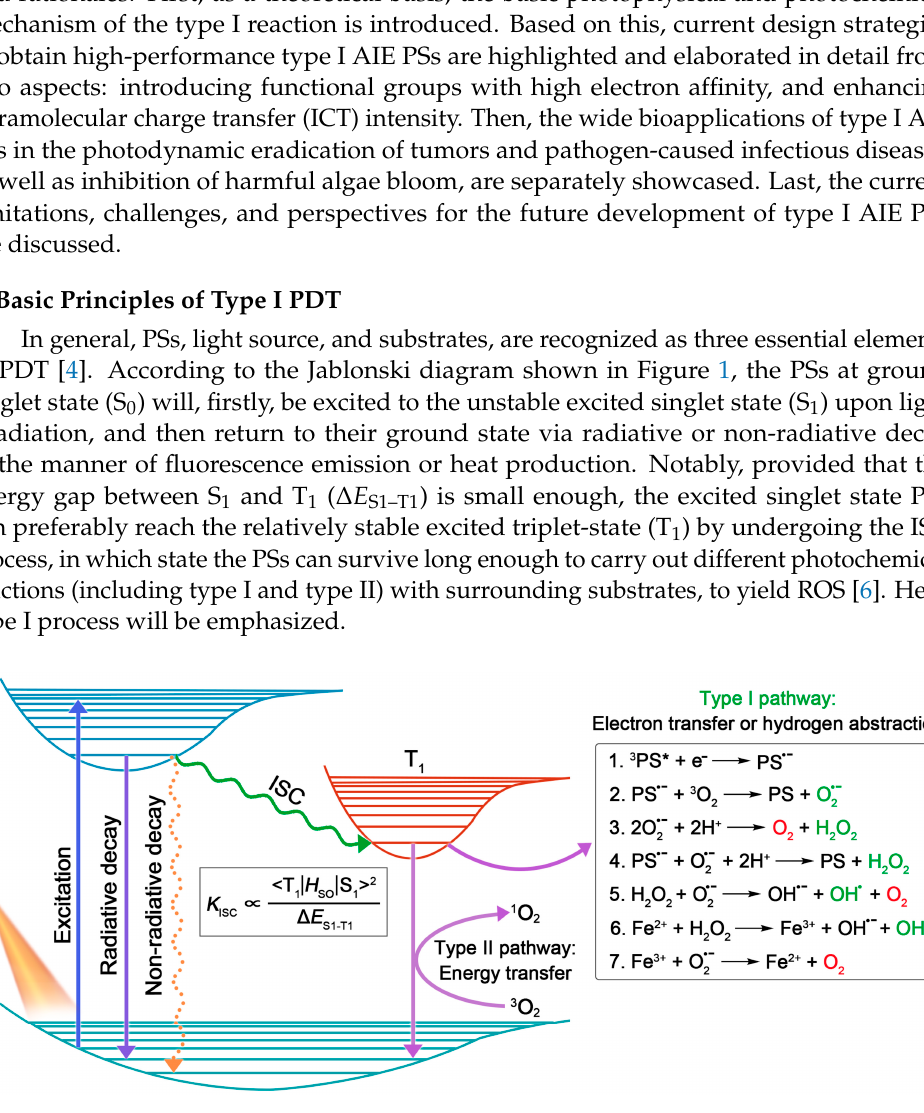
Figure 1. The illustration shows the working mechanisms of PSs described with the Jablonski diagram. The inserted box in the middle shows the ISC rate equation. The inserted box on the right shows the related cascaded reactions during the type I process.